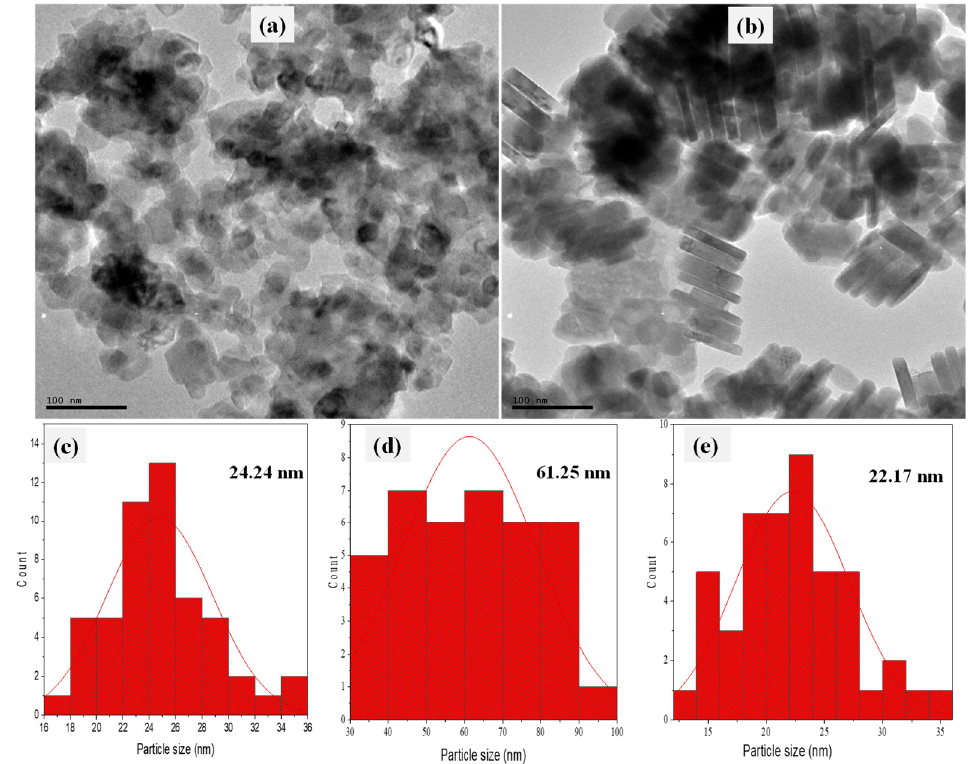
Figure 3. ( a ) TEM micrographs of covellite (CuS) and ( b ) digenite (Cu 9 S 5 ); particle size distribution histograms of ( c ) covellite and ( d , e ) digenite